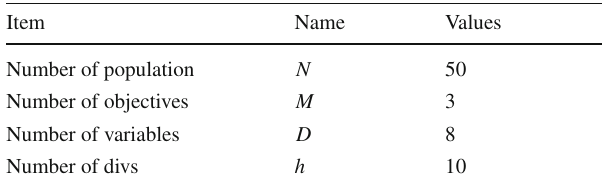
Table 3 Parameters of MOWOA involved in optimization of proposed